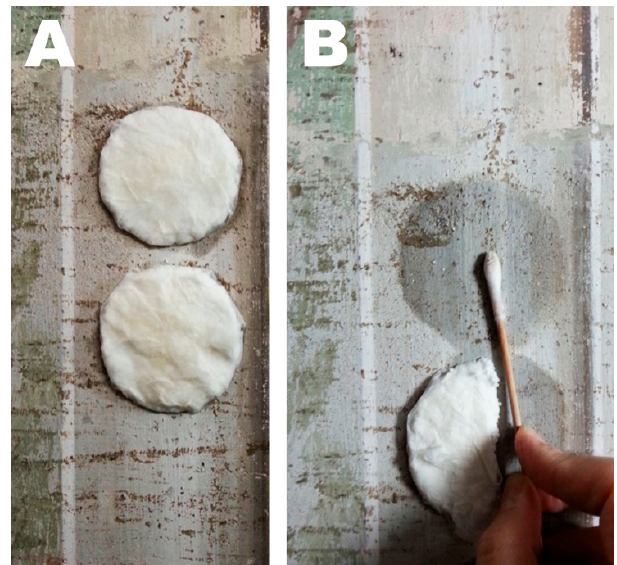
Figure 7. Wax removal tests performed in the Santa Croce Basilica, Florence, Italy. The wax stains appear as brownish concretions, which randomly cover the fresco surface. ( A ) Microemulsion-loaded compresses during the 2.5 h application. ( B ) Mechanical removal of the swollen and softened wax deposits by means of a humid cotton swab. Wax removal is evidenced by the brownish staining of the cotton swab tip.